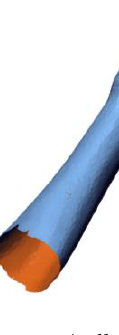
Figure 14. Arm model (blue) and hand support (yellow) correctly positioned. The occlusions generated by the obstacle (yellow) are considered in the analysis).